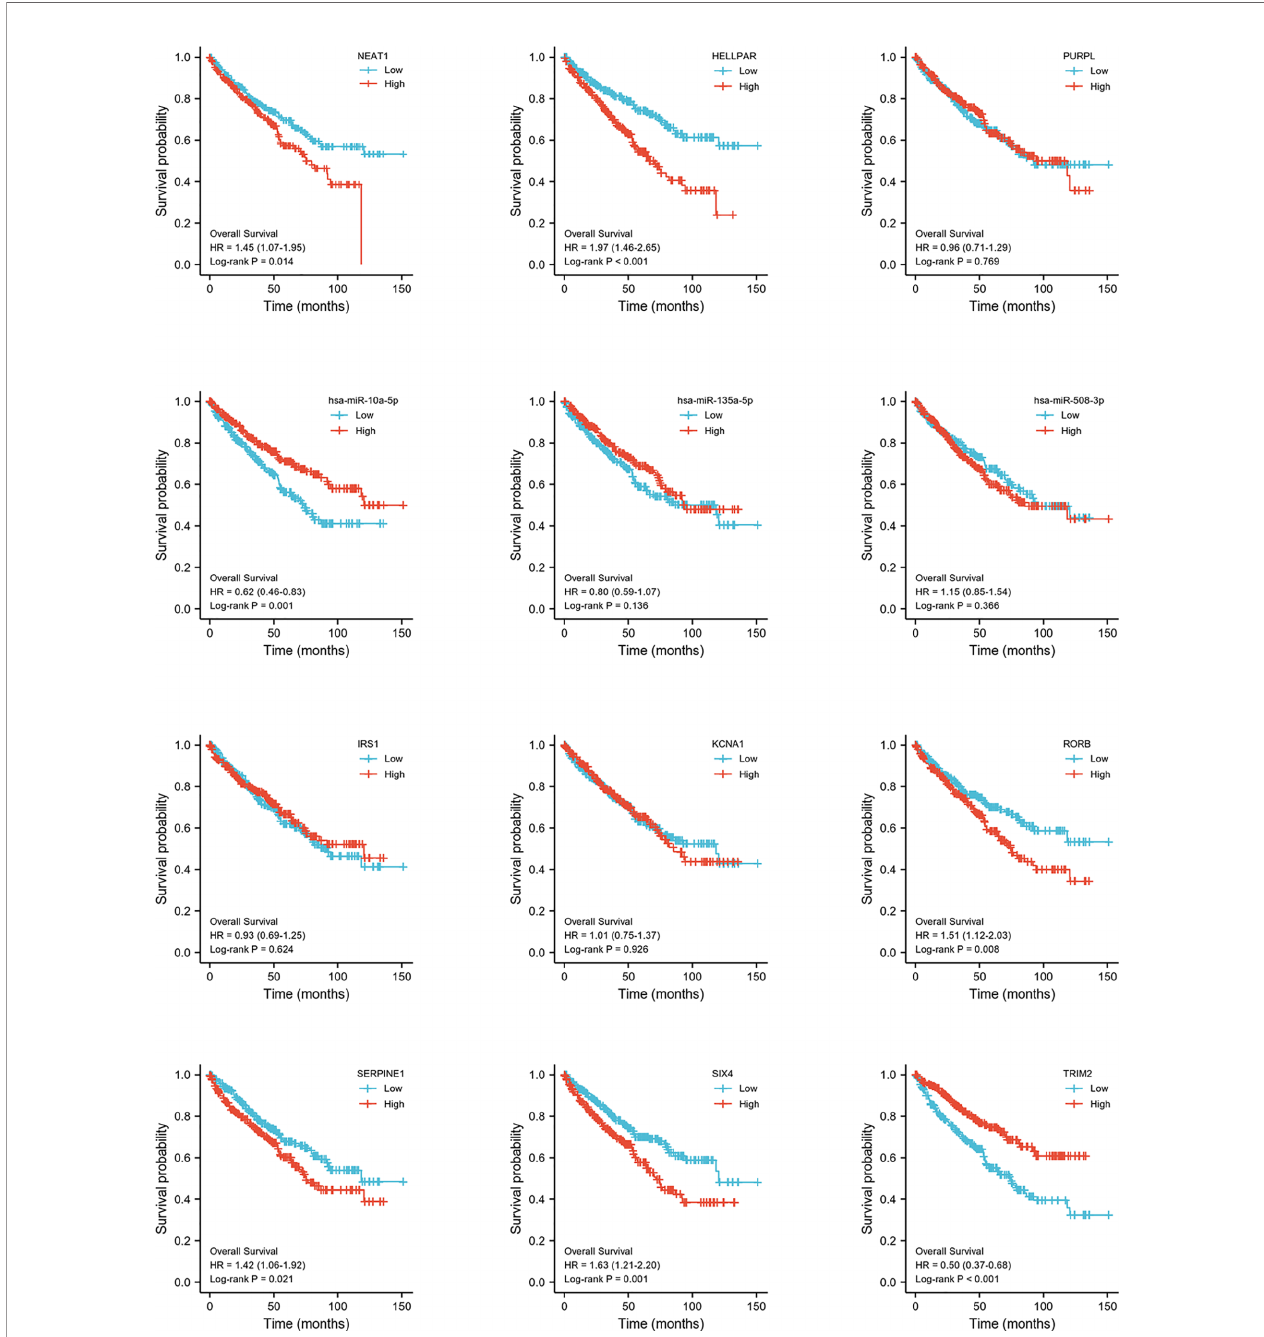
FIGURE 6 | Hub genes survival analysis. Survival analysis of 12 hub genes (3 lncRNAs, 3 miRNAs, 6 mRNAs) comparing high- and low expression